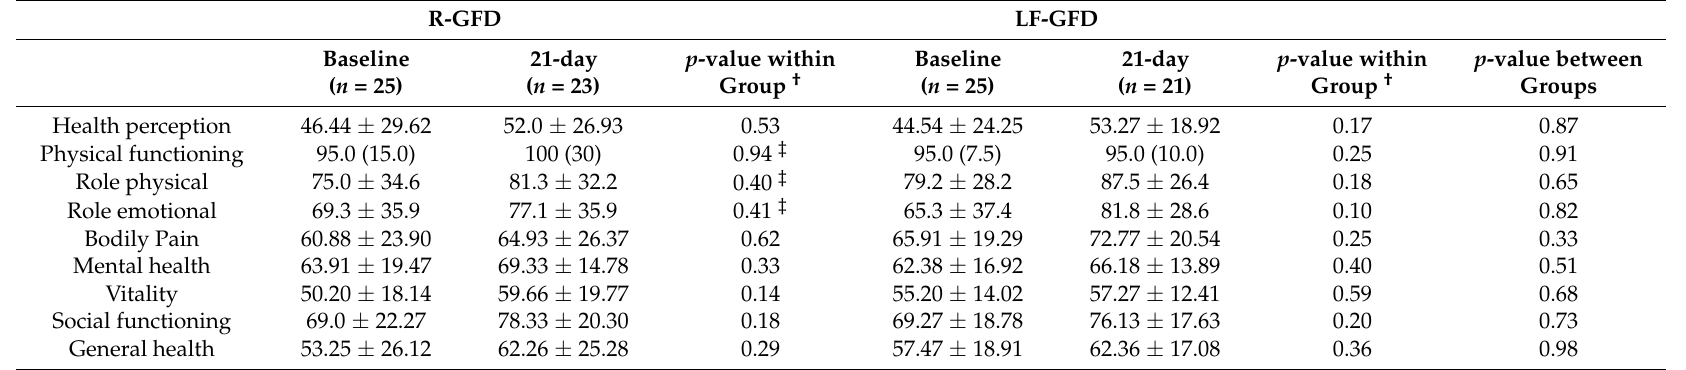
Table 4. Short Form (36) Health Survey (SF-36) subscales and global score 1